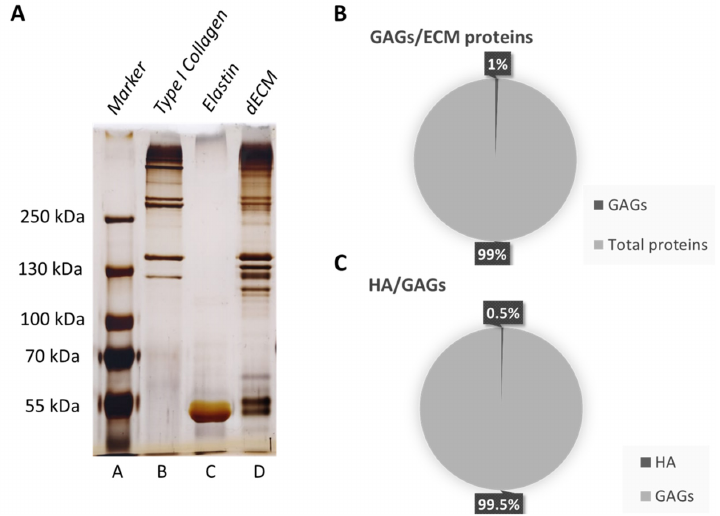
Figure 1. Matrix composition characterization. ( A ) Silver staining on SDS-PAGE gel electrophoresis. A: Protein marker peqGold, B: collagen type I standard, C: elastin standard and D: dECM. ( B ) ELISA evaluation of GAGs in dECM. Percentage presence of GAGs over the total dECM proteins. ( C ) ELISA evaluation of HA in dECM. Percentage presence of HA over the total GAGs amount. The presence of other bands not corresponding to any of the used standards shows that other proteins are present, whose molecular weight might correspond to GAGs,